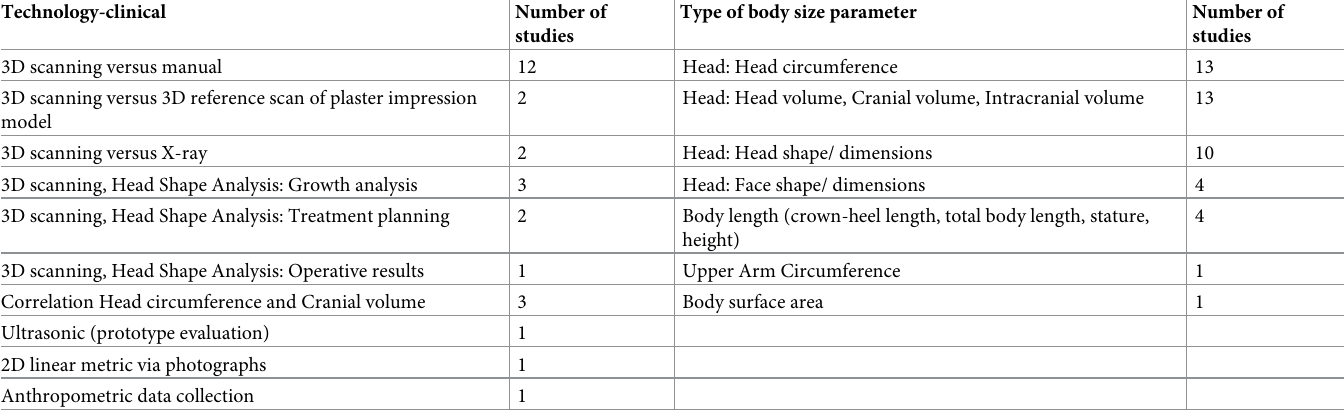
Table 2. Categorized aims of